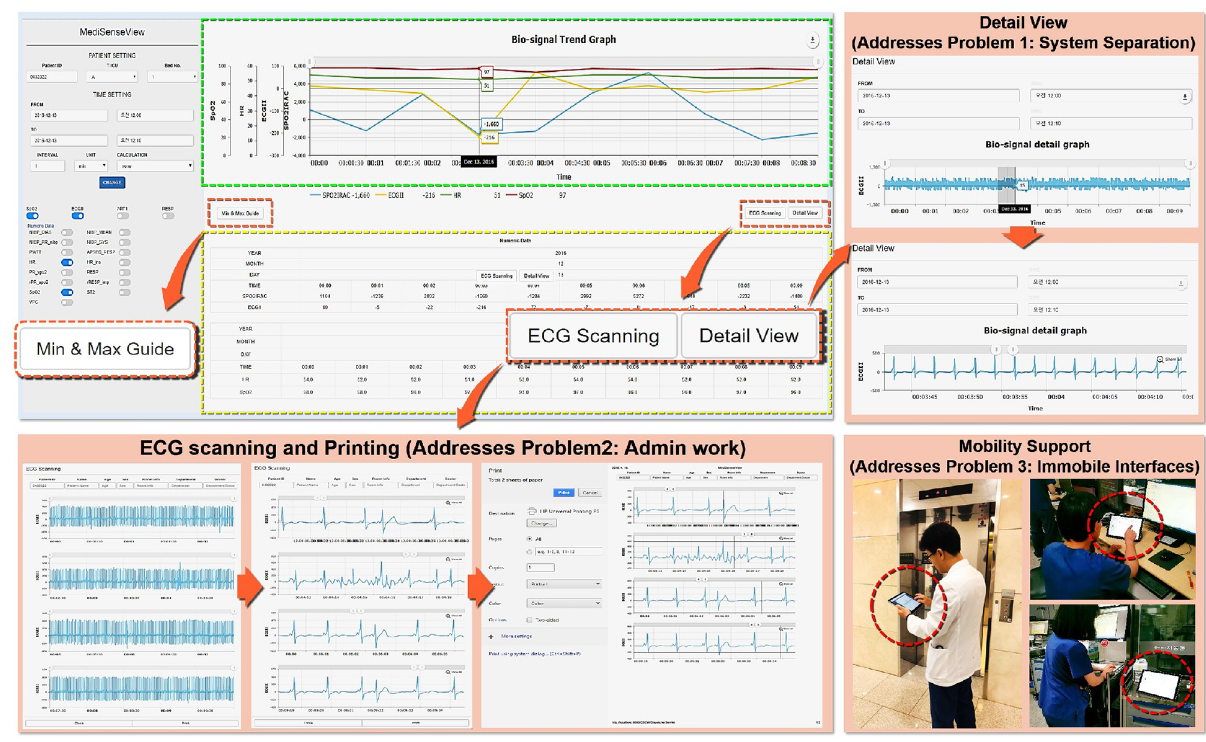
Fig 6. Final version of the MediSenseView prototype. This version was used for the pilot deployments and post-deployment user study. The design process was a result of thee core design meetings with the trauma center staff. To address the core issues for the existing interface systems, MediSenseView combines the data exposed from two separate interfaces, supports mobile usage and eases manual routine tasks. We present how the system reacts to different button-presses and how the final version of MediSenseView resolves all of the three core problems we have identified.